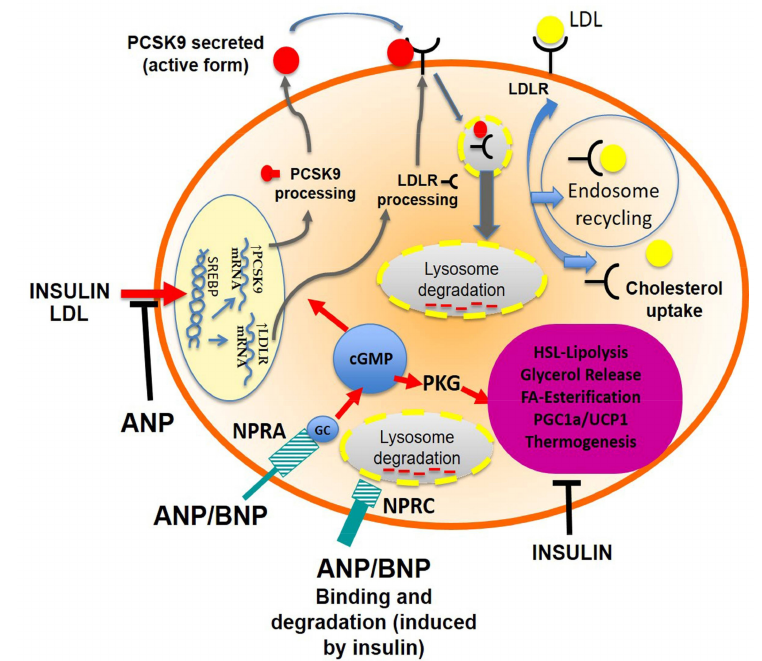
Figure 6. Interactions between insulin and cardiac natriuretic peptides (NPs) in lipid metabolism and PCSK9-LDL receptor handling. The potent lipolytic activity of NPs (ANP and BNP secreted from the heart), mediated by NPRA, is strongly reduced by insulin through the induction of the clearance receptor (NPRC), which binds and degrades NPs. Insulin also induces PCSK9, but this effect is opposed by NPs, especially in conditions simulating hyperglycemia. Overall, the NPs are likely to reduce the triglycerides and to increase cholesterol in human adipocytes, opposing insulin effects. Such activities may also have systemic consequences on blood lipid levels. T-bar arrow indicates inhibitory